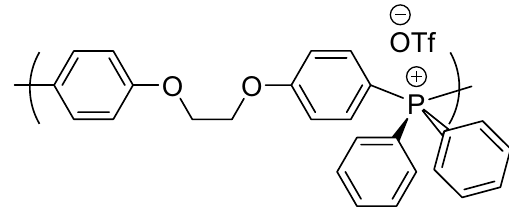
Figure 1. The structure of tetraarylposphonium polymer 19